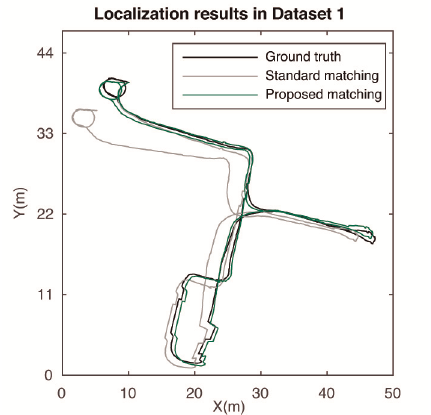
Figure 5. Visual localization results: ground truth (black); standard matching (grey); proposal